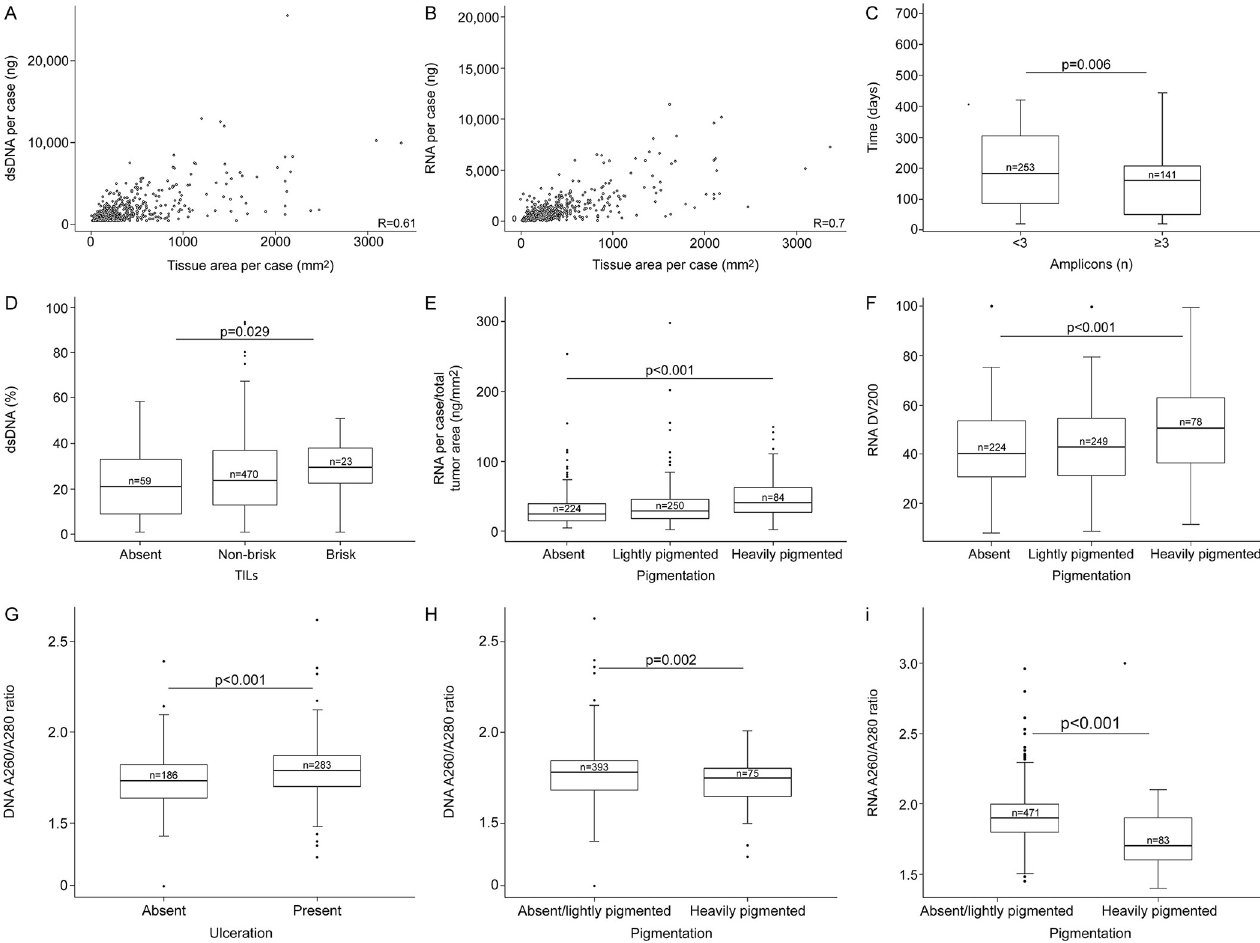
Fig 2. Effect of melanoma characteristics and time elapsed between tissue sectioning and co-extraction, on the quantity and quality of DNA/RNA.